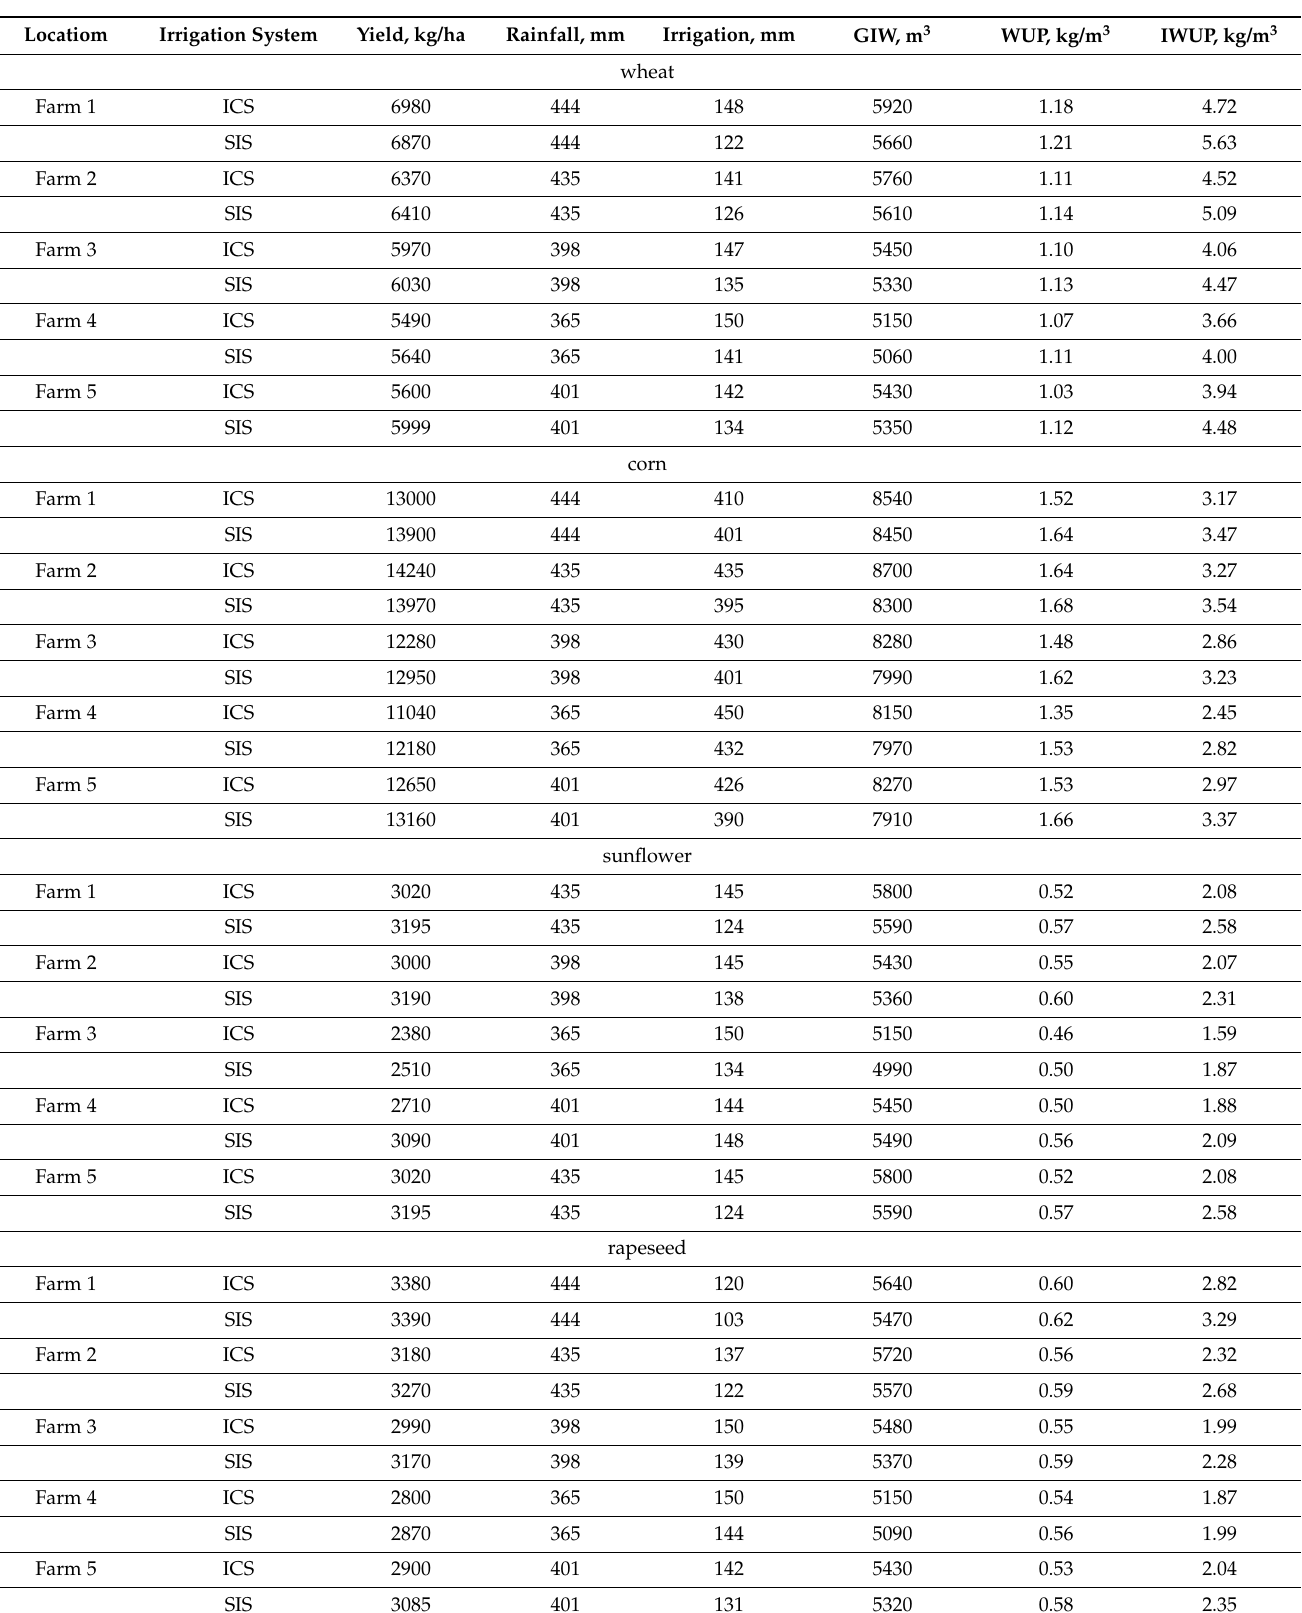
Table 3. Crop Water-Use